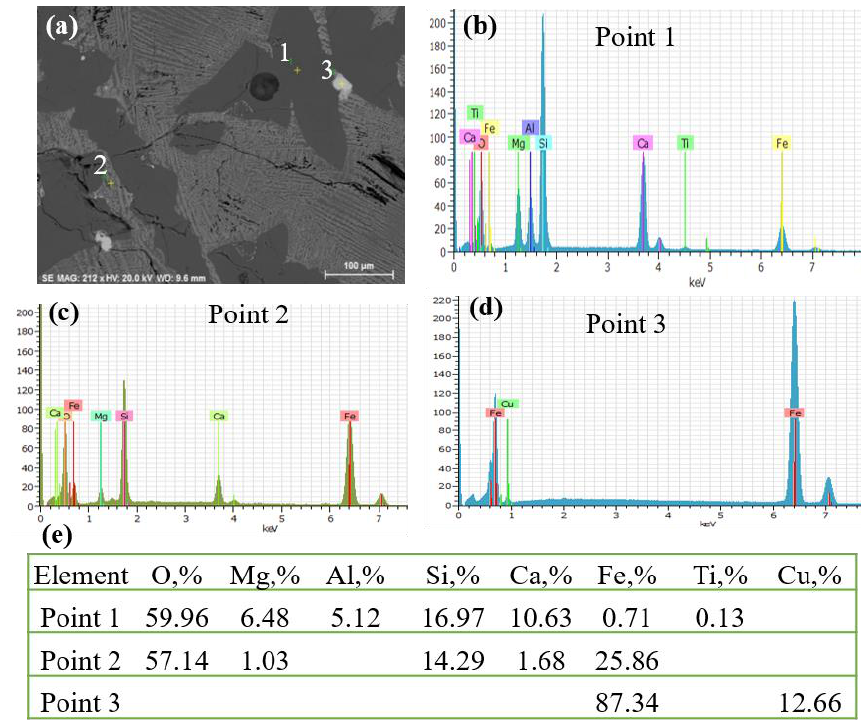
Figure 4. ( a ) SEM of Z3 slag, ( b – d ) EDS patterns at three points, and ( e ) the corresponding elemental composition.